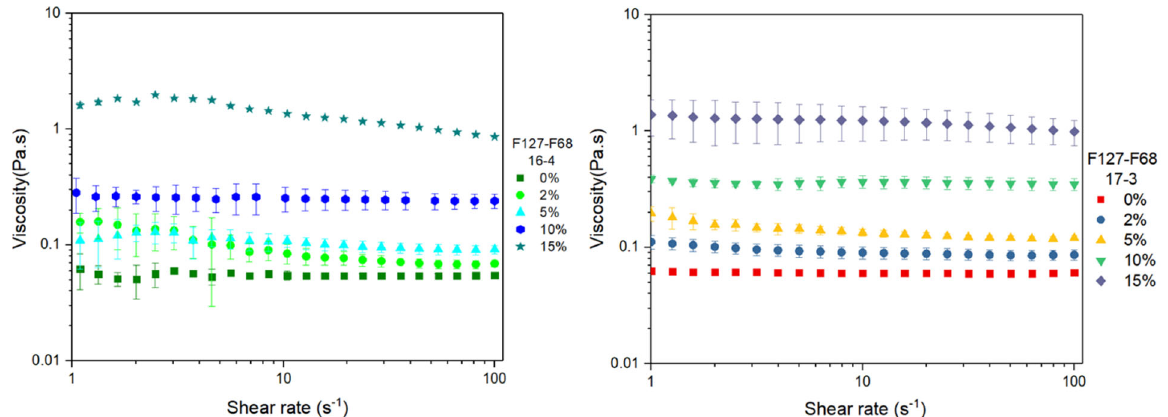
Figure 6. Flow curves of the microparticle–Pluronic hydrogel system with different microparticle concentrations (wt.%) at 21 °C. On the left is a Pluronic ratio of 16:4 and on the right of